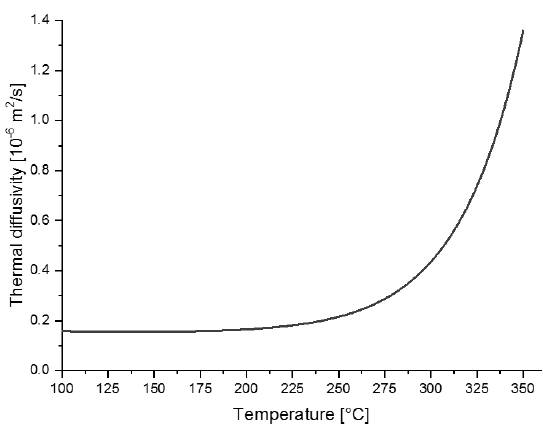
Figure 9. Evolution of the thermal diffusivity with temperature for the material in desorbed state (2 LiH/MgB 2 ), assuming a constant density.